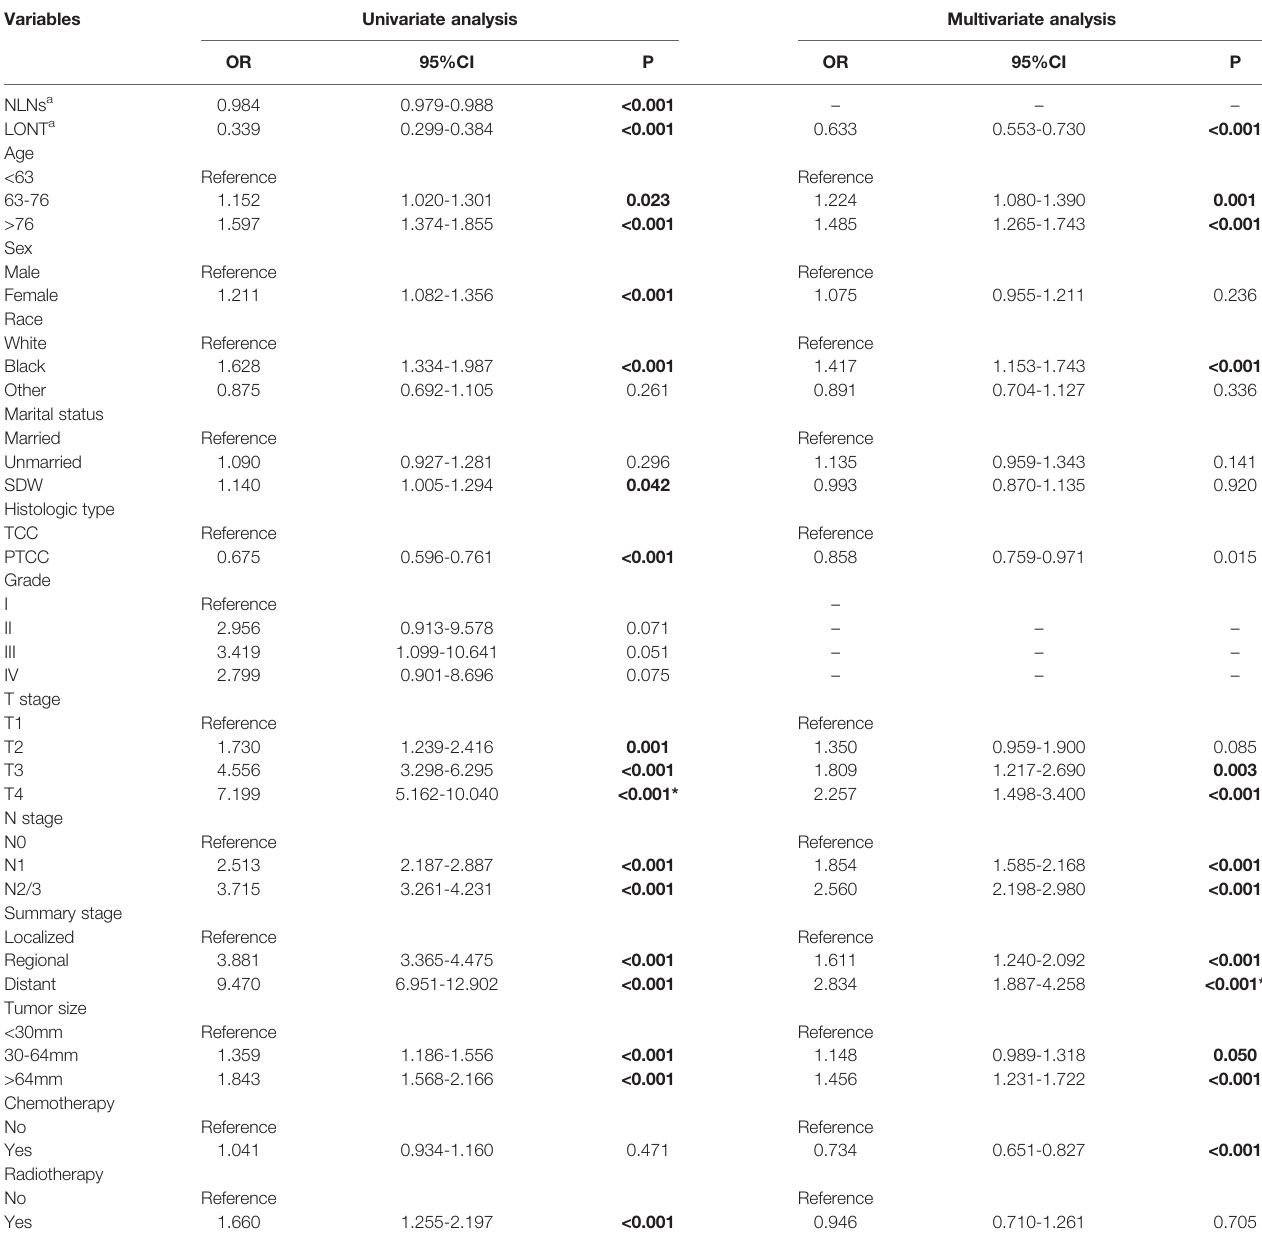
TABLE 4 | Univariate and multivariate Cox regression analyses for cancer-speci fi c survival in the primary